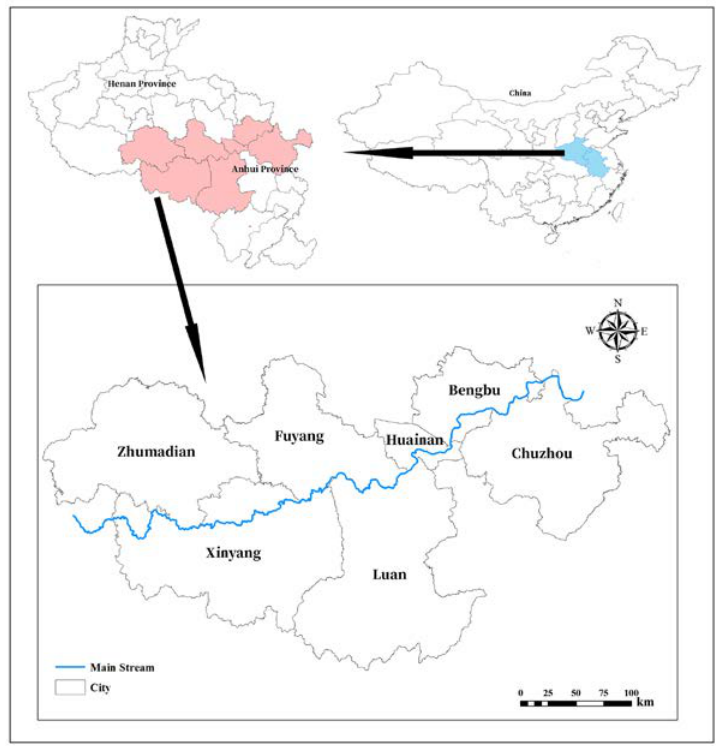
Figure 2. Location of the study area.